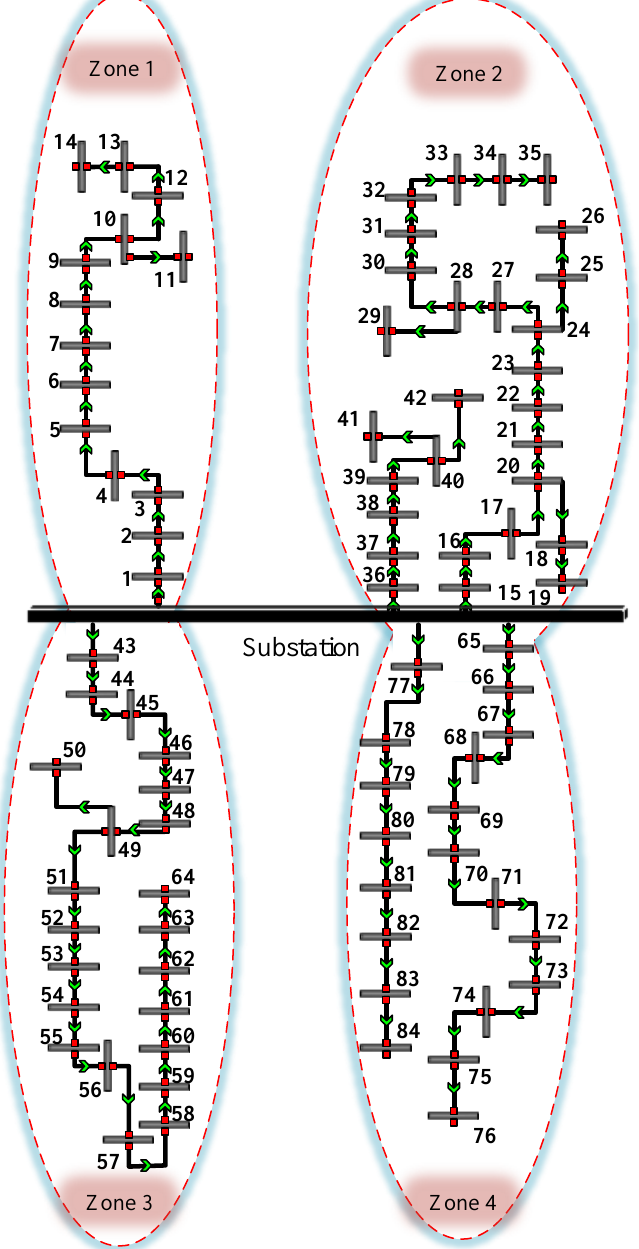
Figure 2. Schematics of the 84-bus grid.